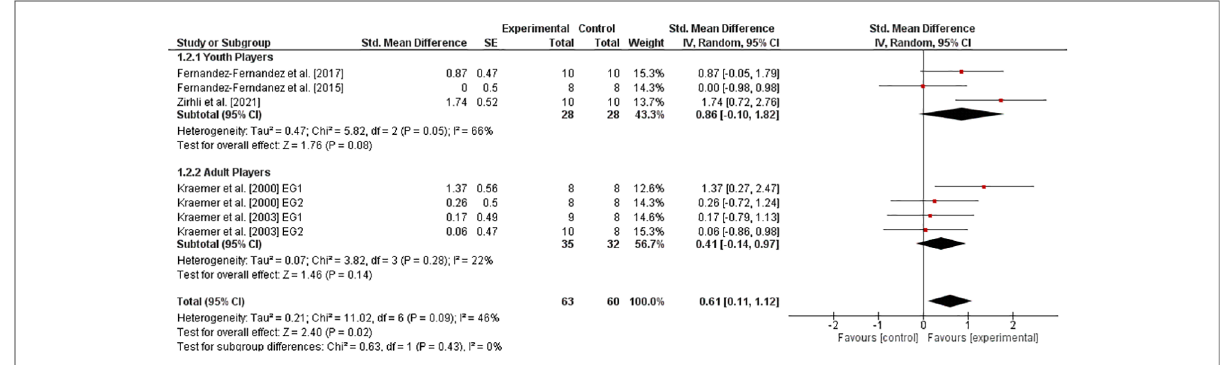
FIGURE 7 Effects of athletic training on measures of endurance (e.g., VO 2 max) in healthy youth and adult tennis players. CI =con fi dence interval, df =degrees of freedom, SE =standard error, IV =inverse variance.